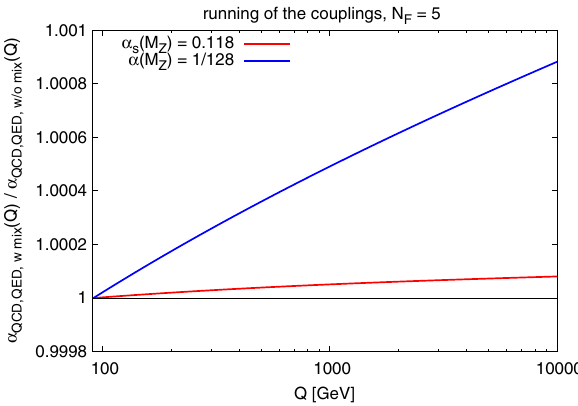
Fig. 11 Comparison between the running with the scale Q of the QCD and QED couplings, α s and α , including or not the mixed terms in the corresponding β -functions. The curves are normalised to the result of the respective coupling running without the mixed terms included in the β functions